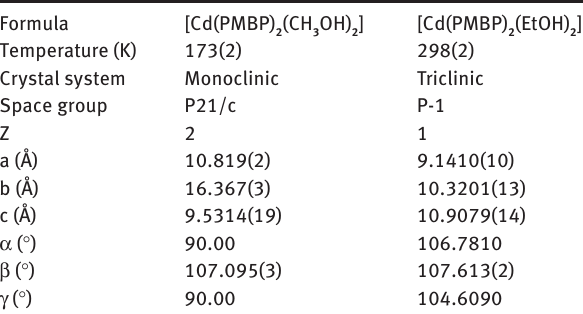
(CH OH) ] and 2 3 2